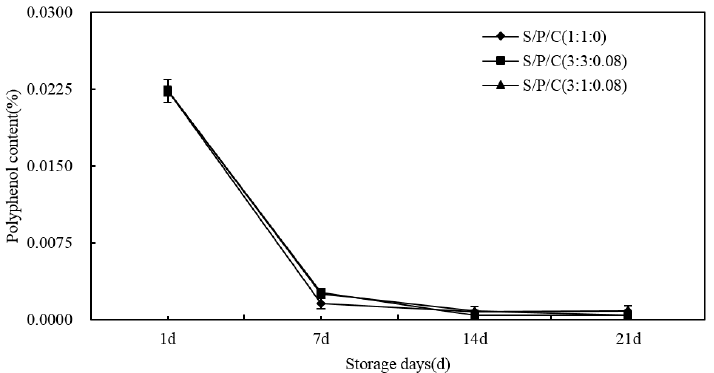
Figure 9. Effect of starch/polyvinyl alcohol/citric acid ternary blend functional food packaging films on the content of polyphenols.